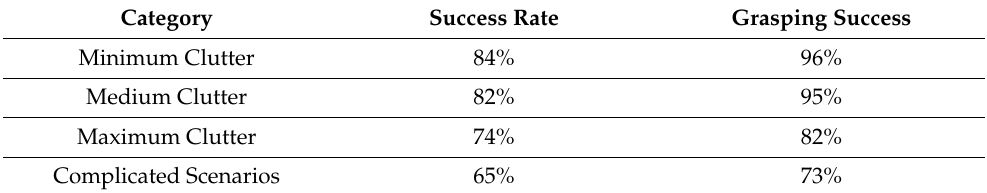
Table 1. Average Test Results